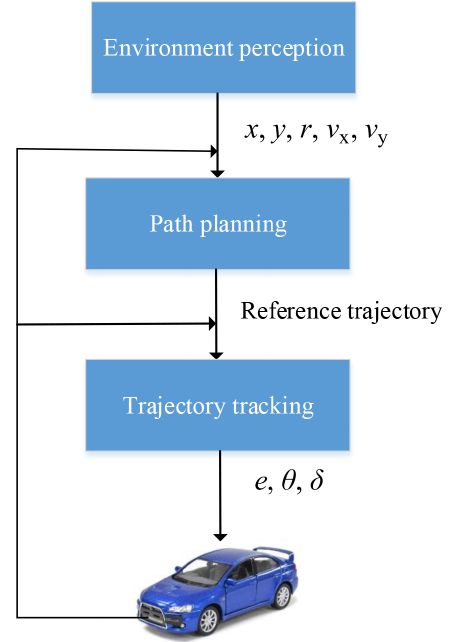
Figure 1. General structure of autonomous